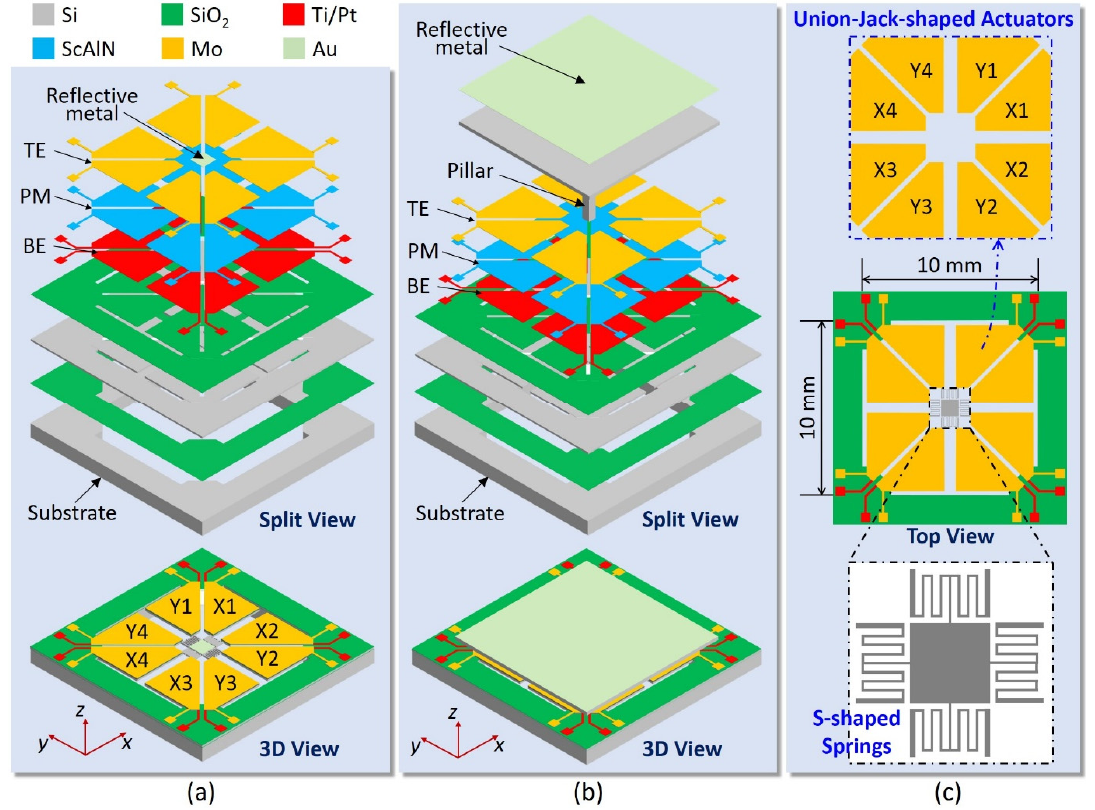
Figure 1. Architectures of two Sc x Al 1-x N-based micro-electro-mechanical systems (MEMS) mirrors: ( a ) Device A, ( b ) Device B, ( c ) Union Jack-shaped actuators and S-shaped meandering springs.